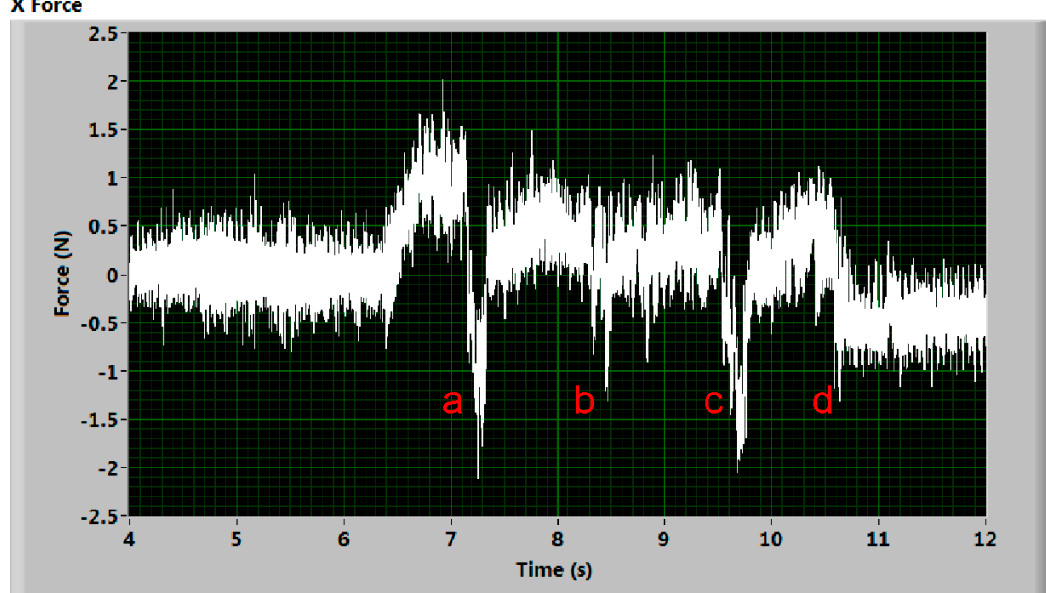
Figure 8. Cutting force signal with presumed uncut parts—tangential force decreases on the uncut material parts (duralumin 2017, traverse speed 400 mm/min). Peaks (a, b, c, d) indicate opposite direction of cutting force on the uncut parts (Figure 9) induced at the end of them.